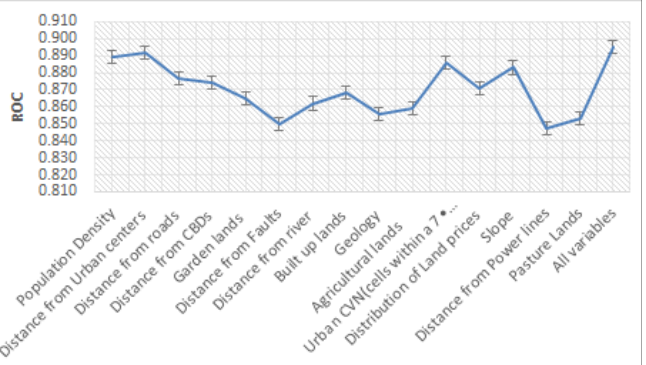
Figure 7. Sensitivity analysis of the logistic regression model by the elimination of independent variables for the 1984–2018 period with ROC fluctuation.